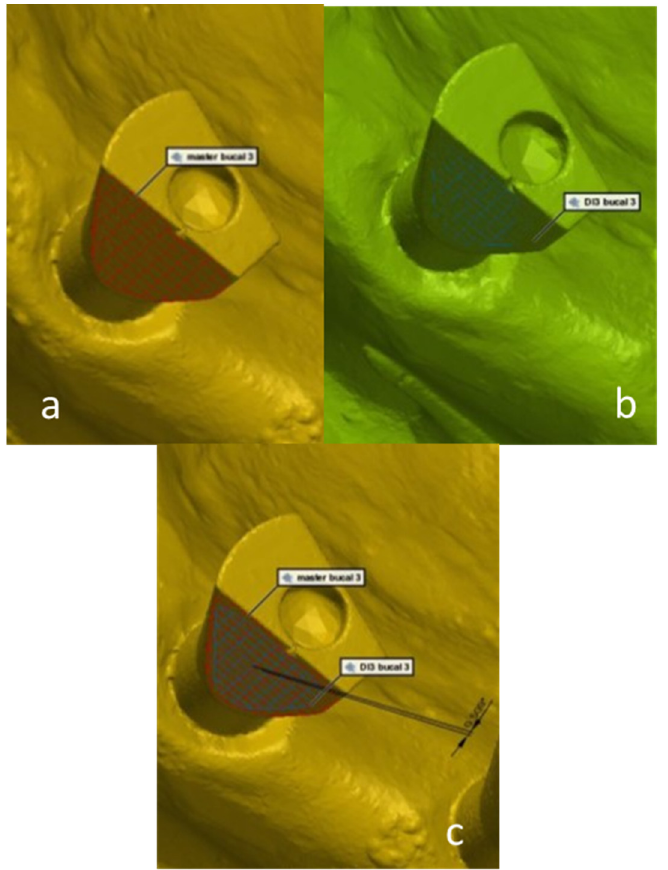
Figure 6. A digital 3D measurement of the angle between each matching scan abutment buccal surface in the study model compared to the master model. ( a )—master model scan; ( b )—study group scan; ( c )—master model scan digitally overlapped with study group scan.